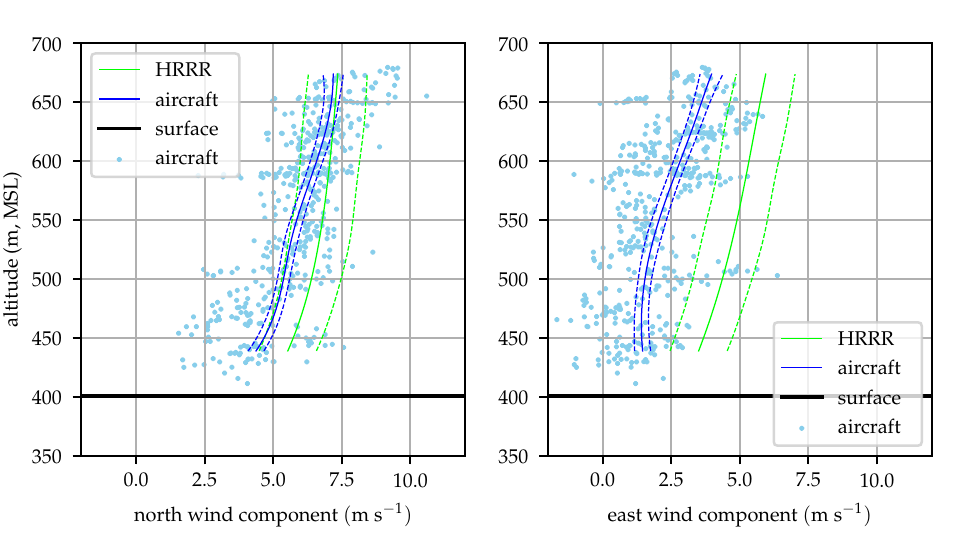
Figure 21. Aircraft measured and HRRR predicted wind profiles at 16:00 local time